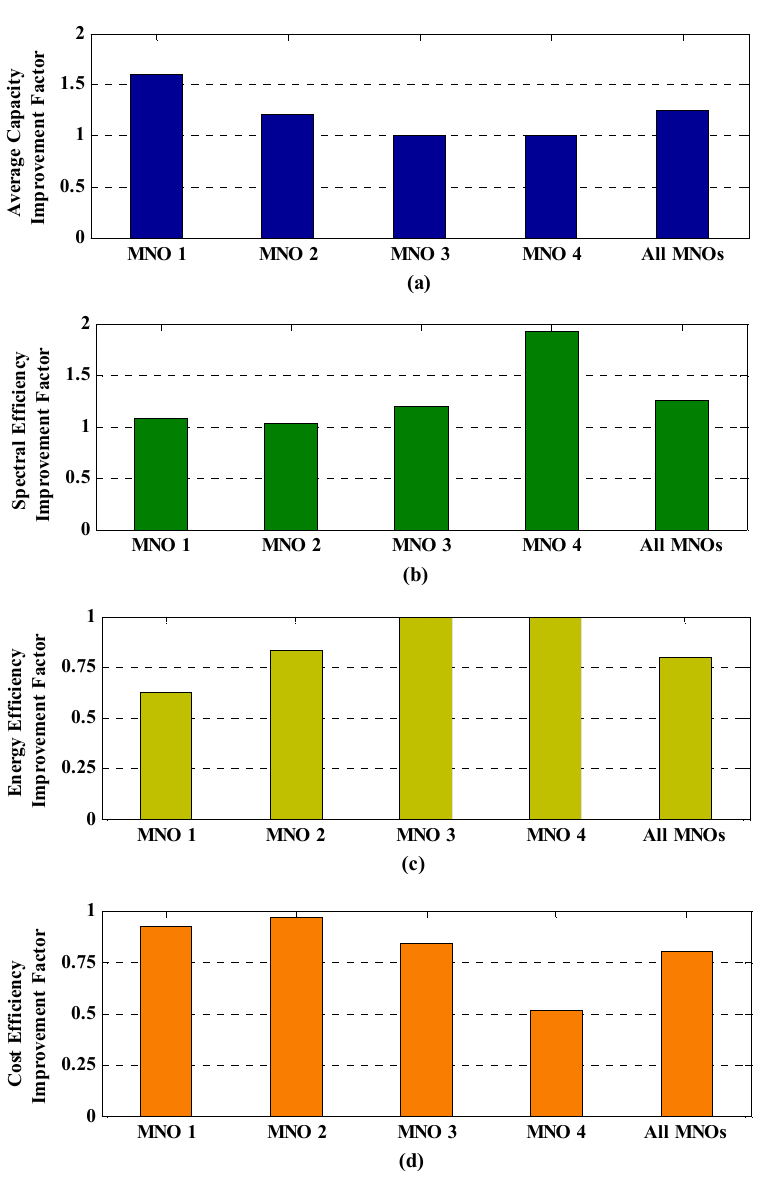
Figure 5. Average capacity, SE, EE, and CE improvement factors of all MNOs due to applying DESA for L = 1: ( a ) average capacity; ( b ) SE; ( c ) EE; and ( d ) CE.